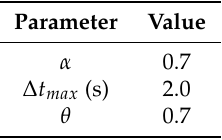
Table 2. Modelling parameters.